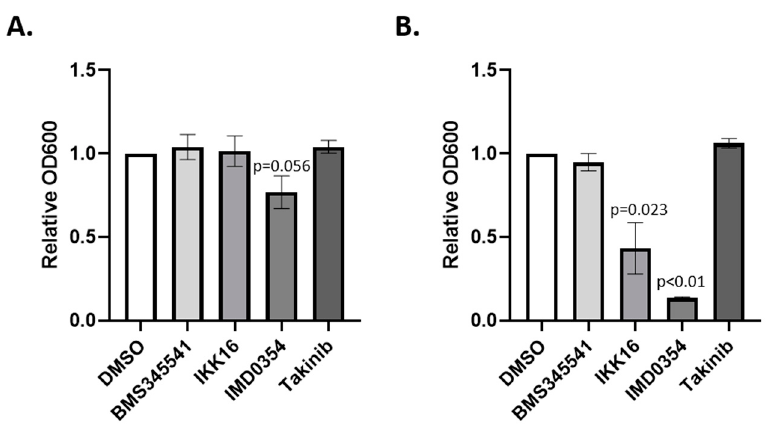
Figure 4. Direct effects of NF-kB signaling inhibitors on entomopathogenic bacteria in culture. Inhibitors dissolved in DMSO were added to bacterial cultures at a final concentration of 10 µ g/mL. Cultures were shaken overnight at room temperature and bacterial growth was quantified by measurement of OD 600 on a spectrophotometer. ( A ) Pseudomonas entomophila. ( B ) Bacillus thuringiensis israelensis . Shown is the mean ± SEM from 3 independent biological replicates. Differences in growth relative to the DMSO control (set at 1) were assessed by 1 sample t -test.